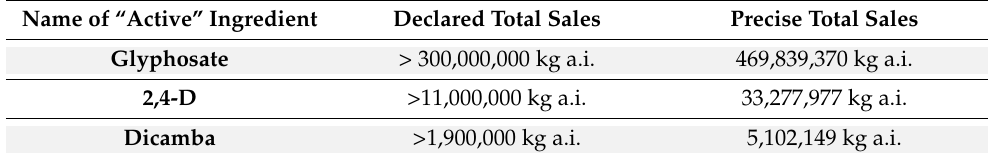
Table 1. Precise Canadian total sales of glyphosate, 2,4-D and dicamba in kilograms of active ingredi- ent (kg a.i.), from 2007 to 2018, obtained through a request made under the Access to Information Act compared to the declared total sales in government’s sales